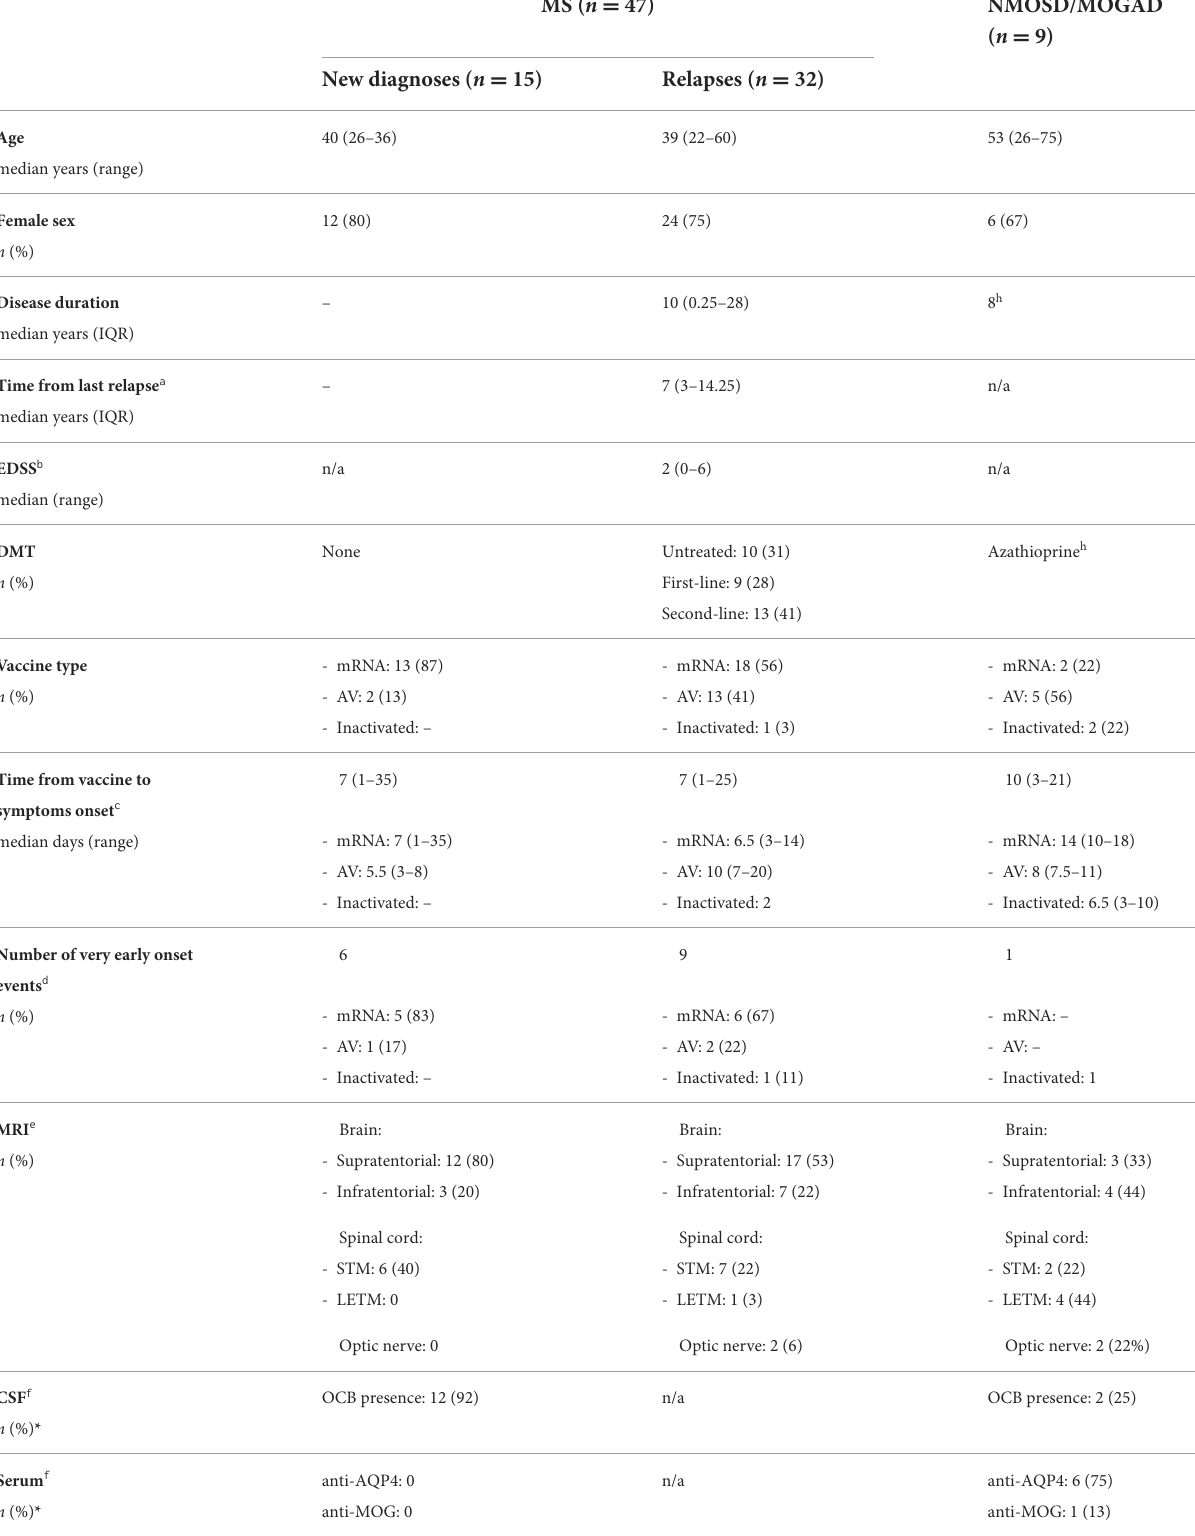
TABLE 2 Characteristics of MS and NMOSD/MOGAD after COVID-19